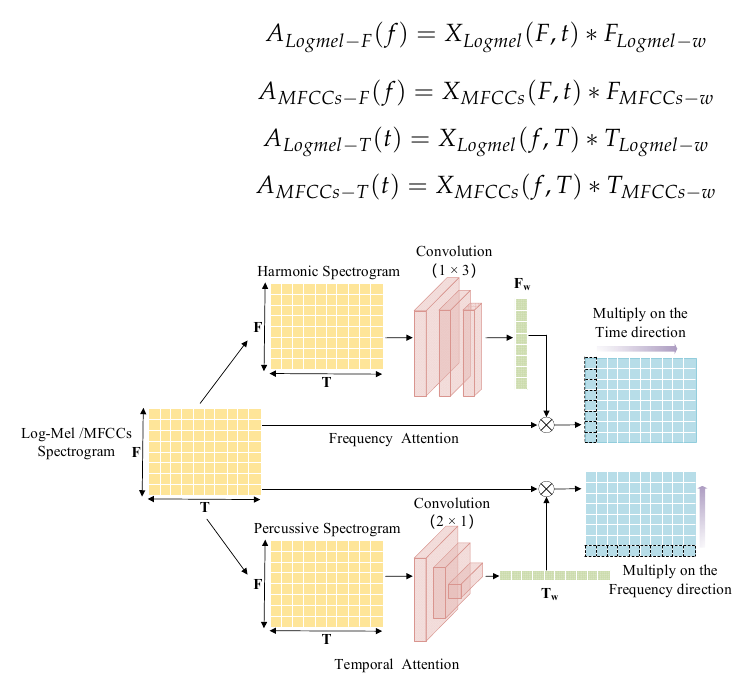
Figure 2. Temporal-frequency attention mechanism.